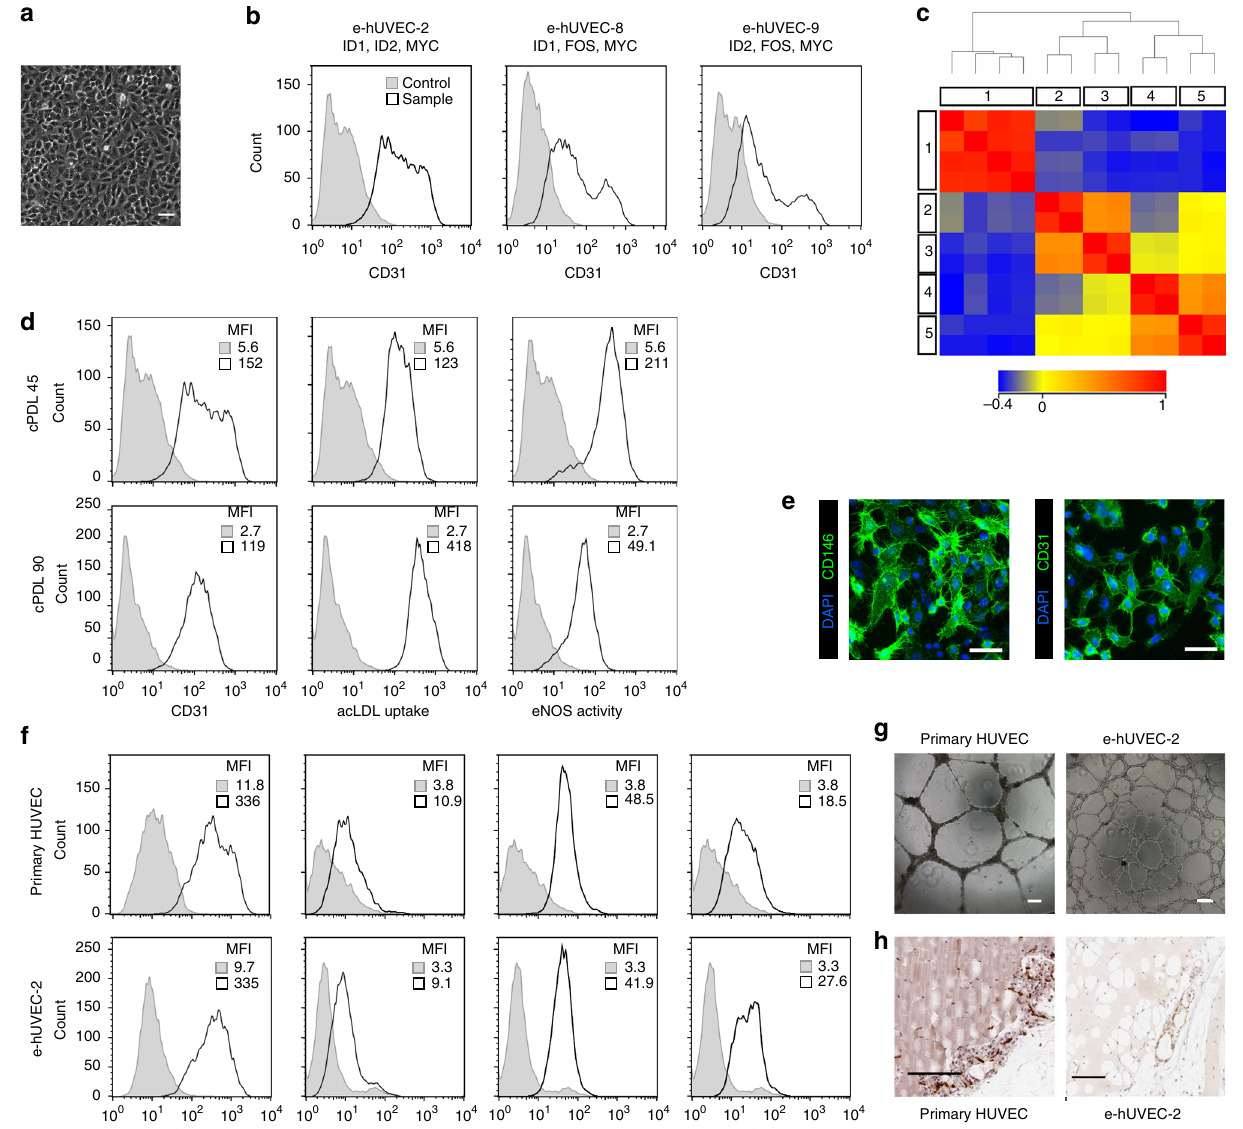
Fig. 3 Comparable phenotype of primary and expanded endothelial cells. a Phase contrast microscopy shows the expandable HUVEC cell line e-hUVEC-2 (MYC, ID1, and ID2). Scale bar 100 µ m. b CD31 expression of human endothelial cell populations immortalized with three different gene sets as indicated. c Global gene expression analysis was performed on three different HUVEC lines (e-hUVEC-2, 8 and 9; in duplicate) (3, 4, 5, respectively) and two independent primary HUVEC populations (2) as well as four primary gingiva fi broblast populations (1). Expression data was processed with GeneSpring 11.5.1 software and a Standard Pearson Correlation was determined for each gene versus all other genes. The correlation heatmap depicts the pair-wise correlation coef fi cient between the given samples and displays the relationship between the different samples. The samples are clustered based on the pair-wise correlation coef fi cients between all entities. d Phenotypic stability of e-hUVEC-2 cells after 45 and 90 cumulative population doublings was evaluated by CD31 (also known as PECAM1) expression, acetylated LDL uptake, and eNOS activity. Gray fi ll: antibody isotype control; black outline: stained sample. MFI: median fl uorescence intensity. e Immuno fl uorescence-based detection of CD31 and CD146 (also known as MCAM) in expandable HUVECs counterstained for nuclei with DAPI. Scale bars, 100 µ m. f The phenotype and the functionality of cell line e-hUVEC-2 (cumulative population doubling 80) was compared to primary HUVECs based on fl ow cytometric analysis of CD31, TIE1, TIE2, and CD309 (also known as VEGFR2) expression. Gray fi ll: antibody isotype control; black outline: stained sample. MFI: median fl uorescence intensity. g The angiogenic potential of primary HUVECs and e-hUVEC-2 was determined in vitro by a matrigel tube formation assay. Scale bars, 200 µ m. h Spheroids in matrigel of primary HUVEC and e-hUVEC-2 were subcutaneously injected into Rag2 -/- Il2r g − / − mice. After two weeks the implants were dissected and stained for human CD31 (brown color). e-hUVEC-2 organized into human CD31 positive microvessels similar to primary HUVEC. Scale bars, 100 µ